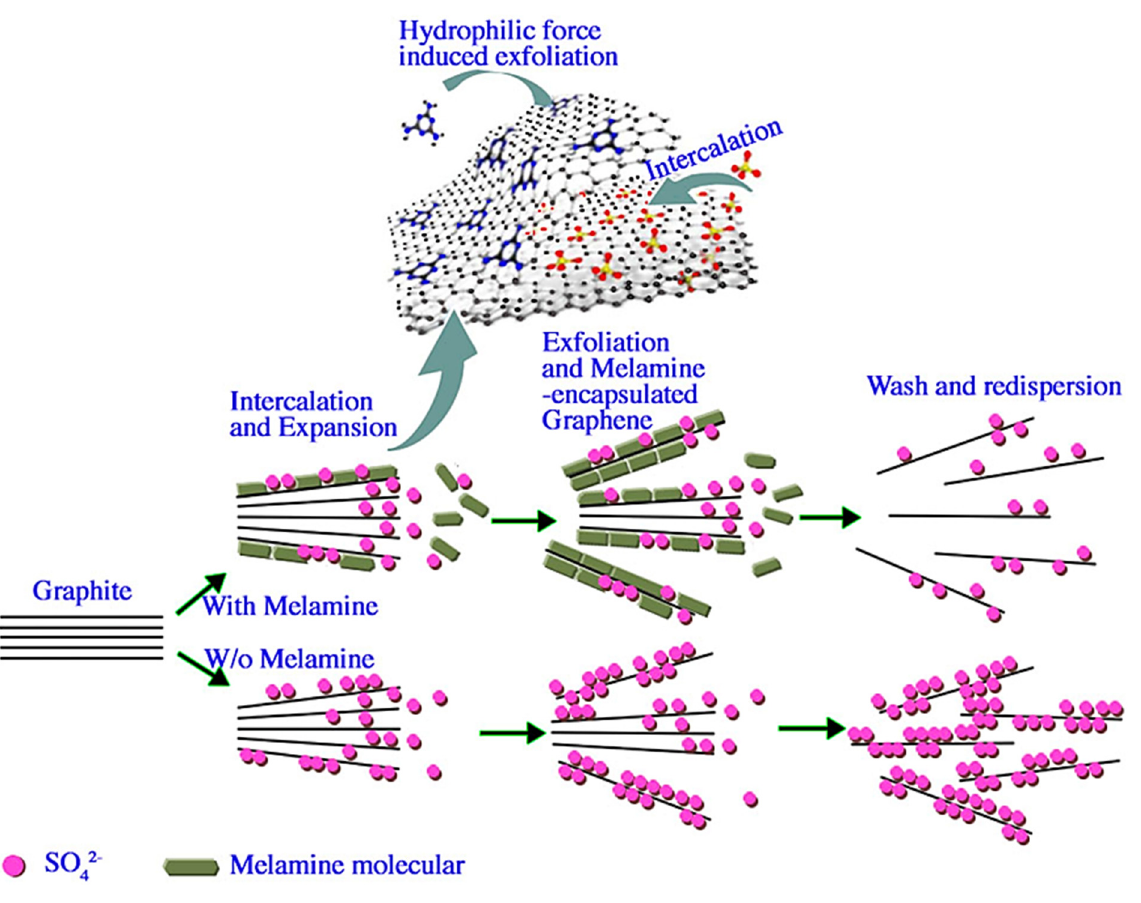
Figure 9. Graphical representation of electrochemical exfoliation process with/without melamine additives. Reconstructed with permission from [81].